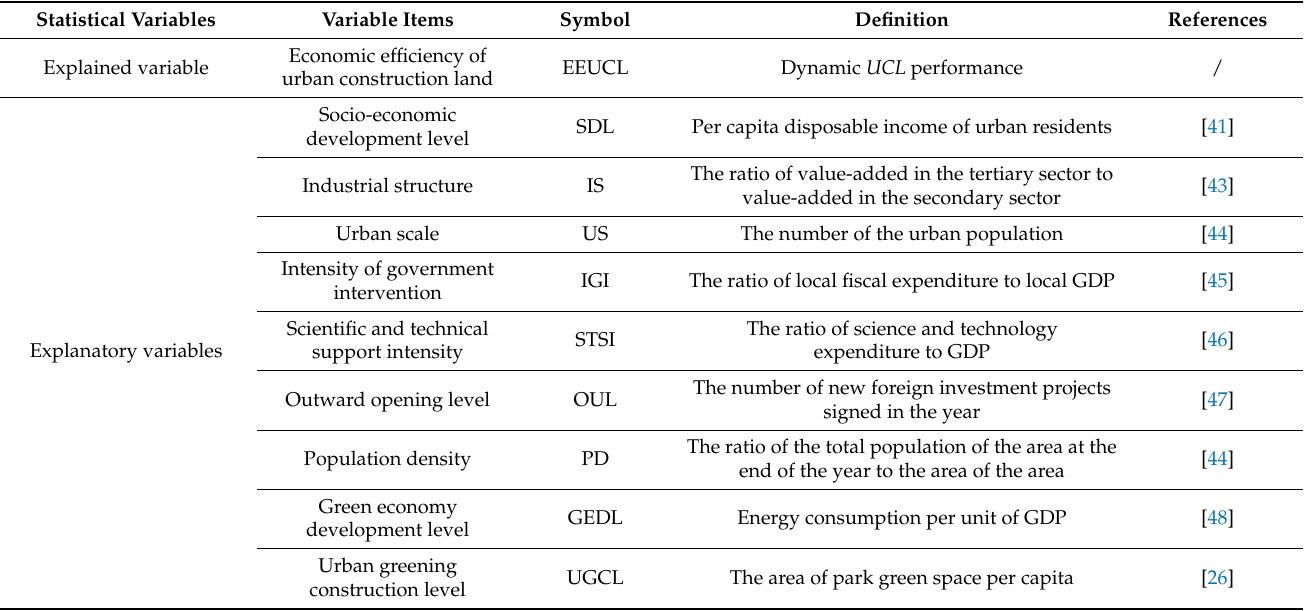
Table 3. Influencing factors index